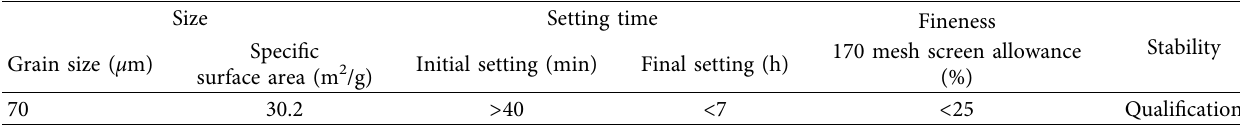
Table 2: Basic properties of lightly burned magnesium oxide powder.